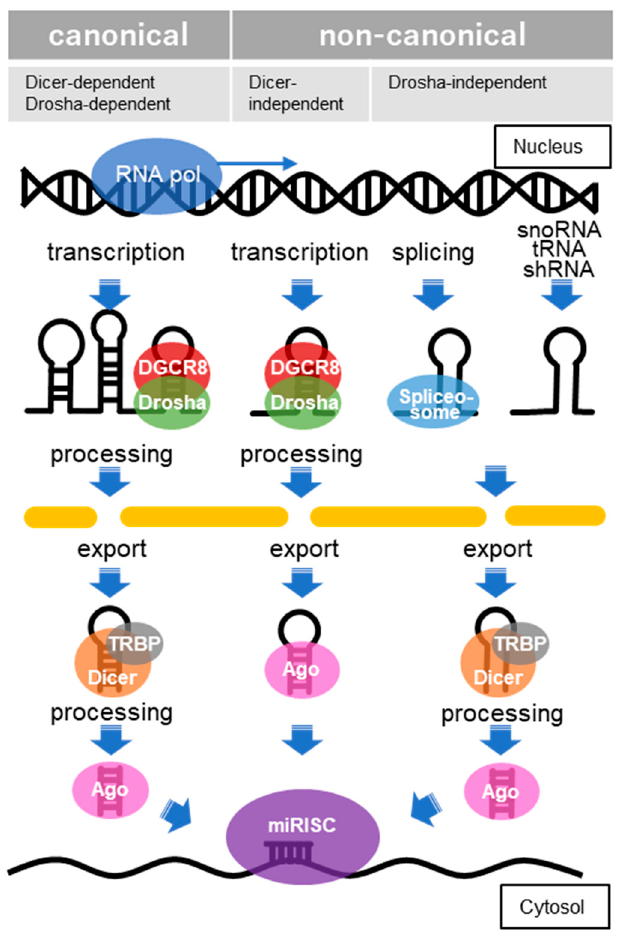
Figure 4. Canonical and non-canonical pathways of microRNA biogenesis.